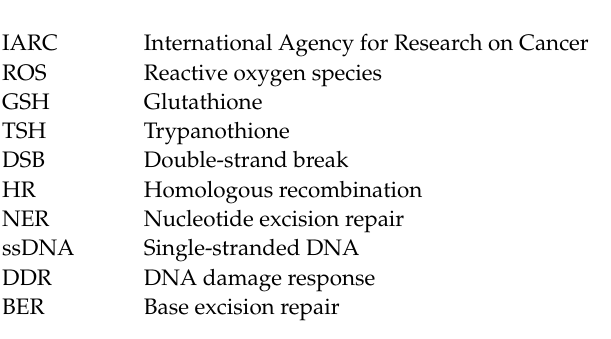
Table S2: Oligonucleotides used in this